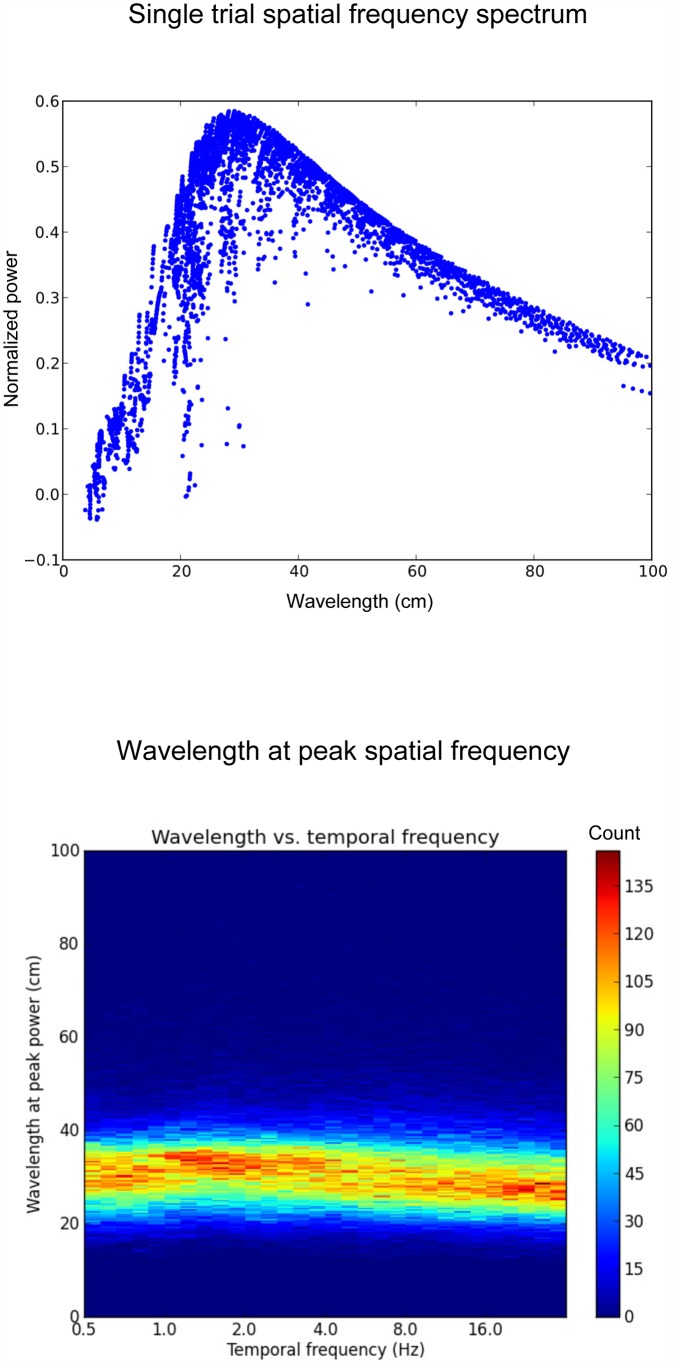
Typical wavelength spectrum and distribution of peak wavelengths over all samples.The top panel shows the spatial frequency spectrum for a single sample of one subject’s MEG. The peak in the wavelength spectrum in this case was at 27cm. The bottom panel shows the distribution of peak spatial frequencies over the entire population of samples. The bulk of waves have wavelength between 25 and 35cm, with delta band (1 to 4Hz) having slightly higher wavelengths compared to beta band (16 to 28 Hz).